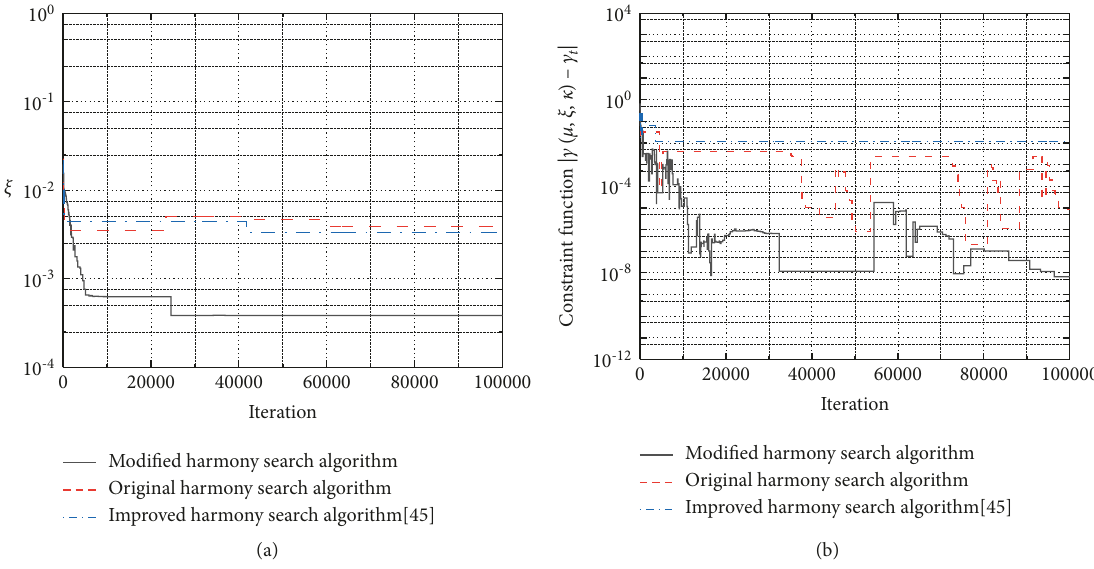
Figure 6: The variation trends of key indices during the optimization process for case 2. (a) The nominal damping ratio ξ . (b) The constraint function | c ( μ , ξ , κ ) − c t |